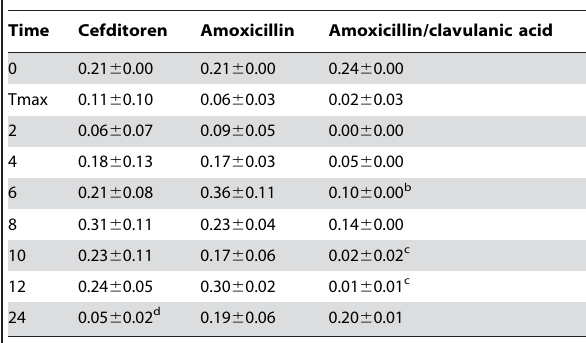
b -lactamase activity (absorbance units) in simulations of bid 400 mg cefditoren, tid 875 mg amoxicillin, and tid 875/125 mg amoxicillin/clavulanic acid regimens. a Tmax: 2.8 h for cefditoren, 1.5 h for clavulanic acid and amoxicillin. b p , 0.01 amoxicillin/clavulanic acid vs. amoxicillin. c p , 0.01 amoxicillin/clavulanic acid vs. amoxicillin and cefditoren. d p , 0.01 cefditoren vs. amoxicillin and amoxicillin/clavulanic acid.